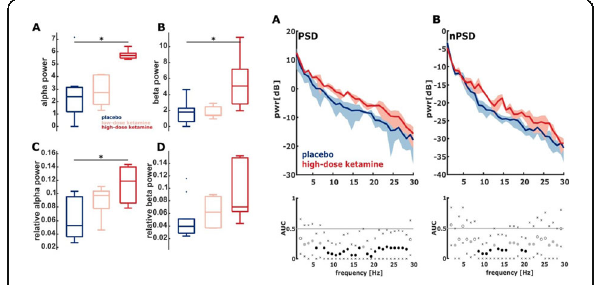
Fig. 1 (abstract 001347). See text for